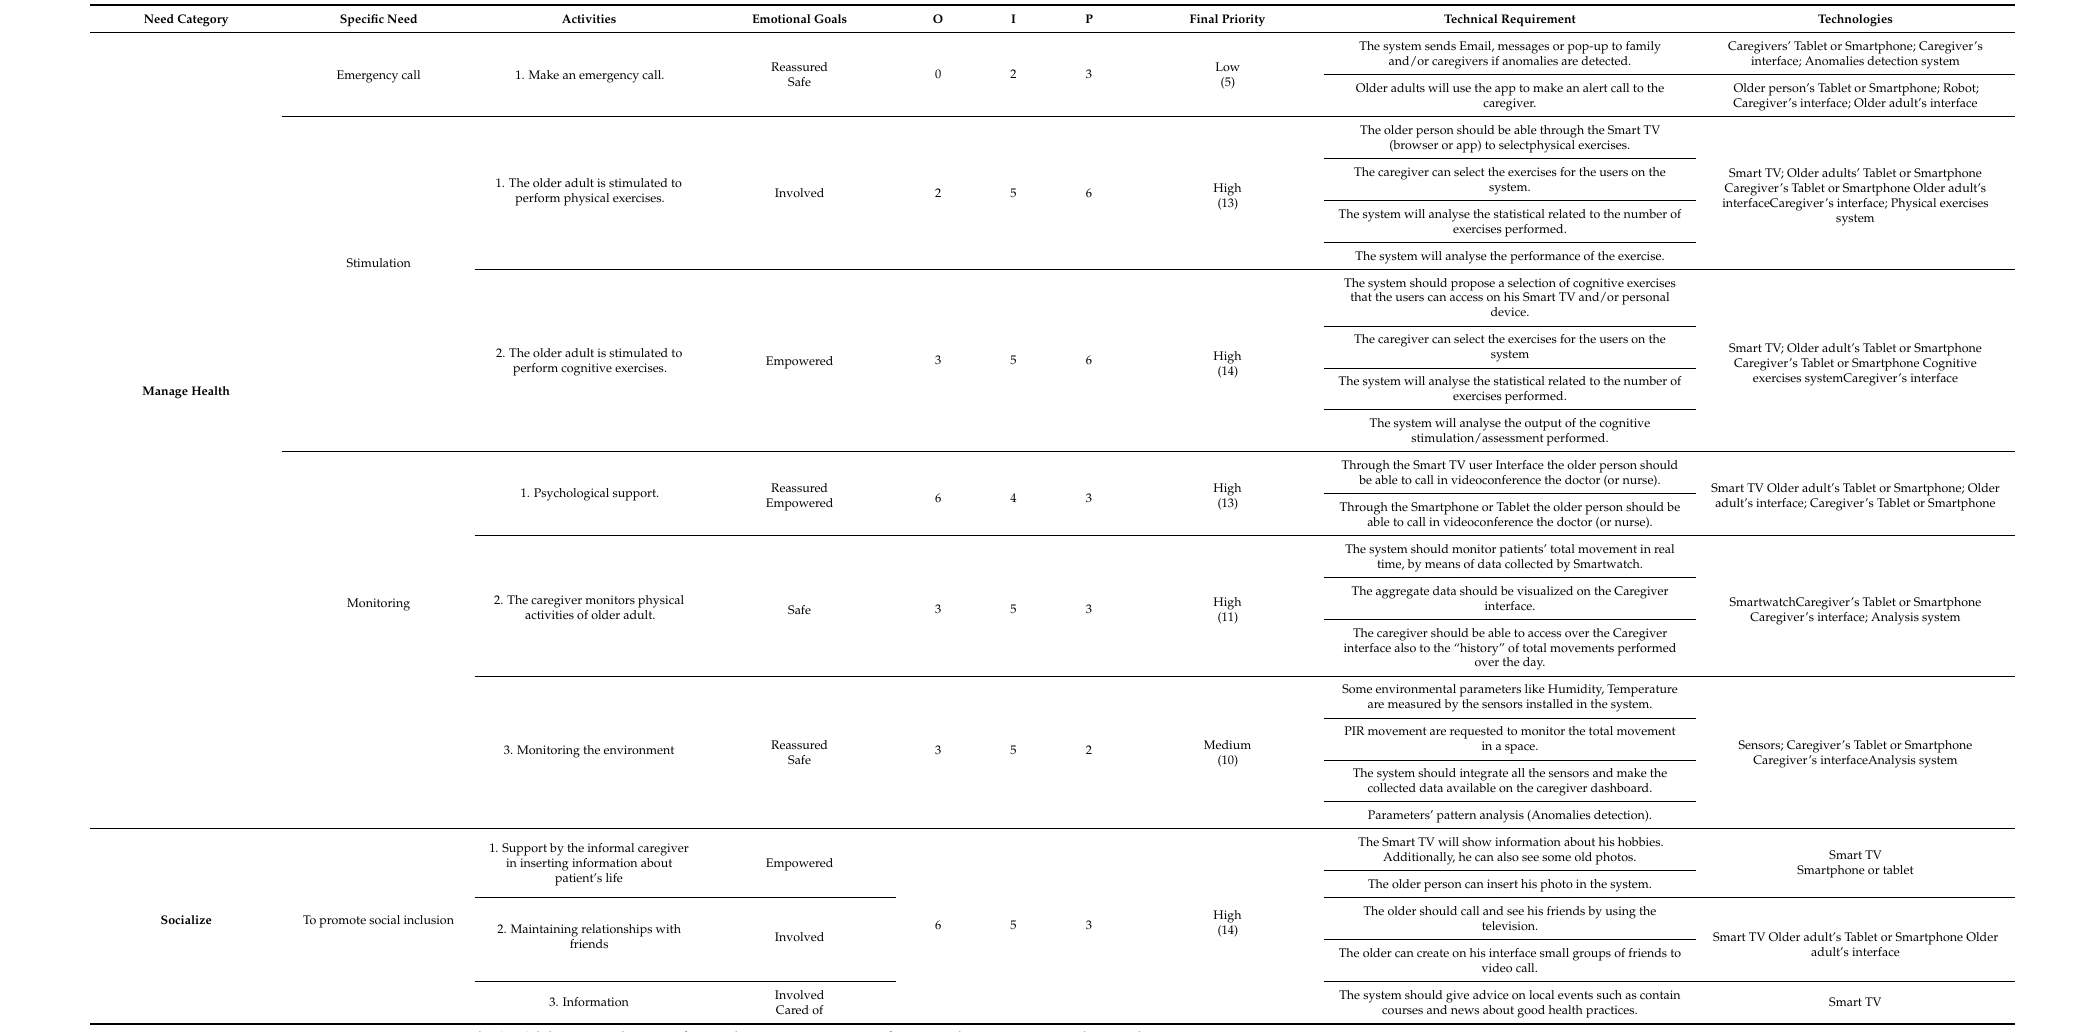
Table 3. Prioritization Analysis of services according to needs of the